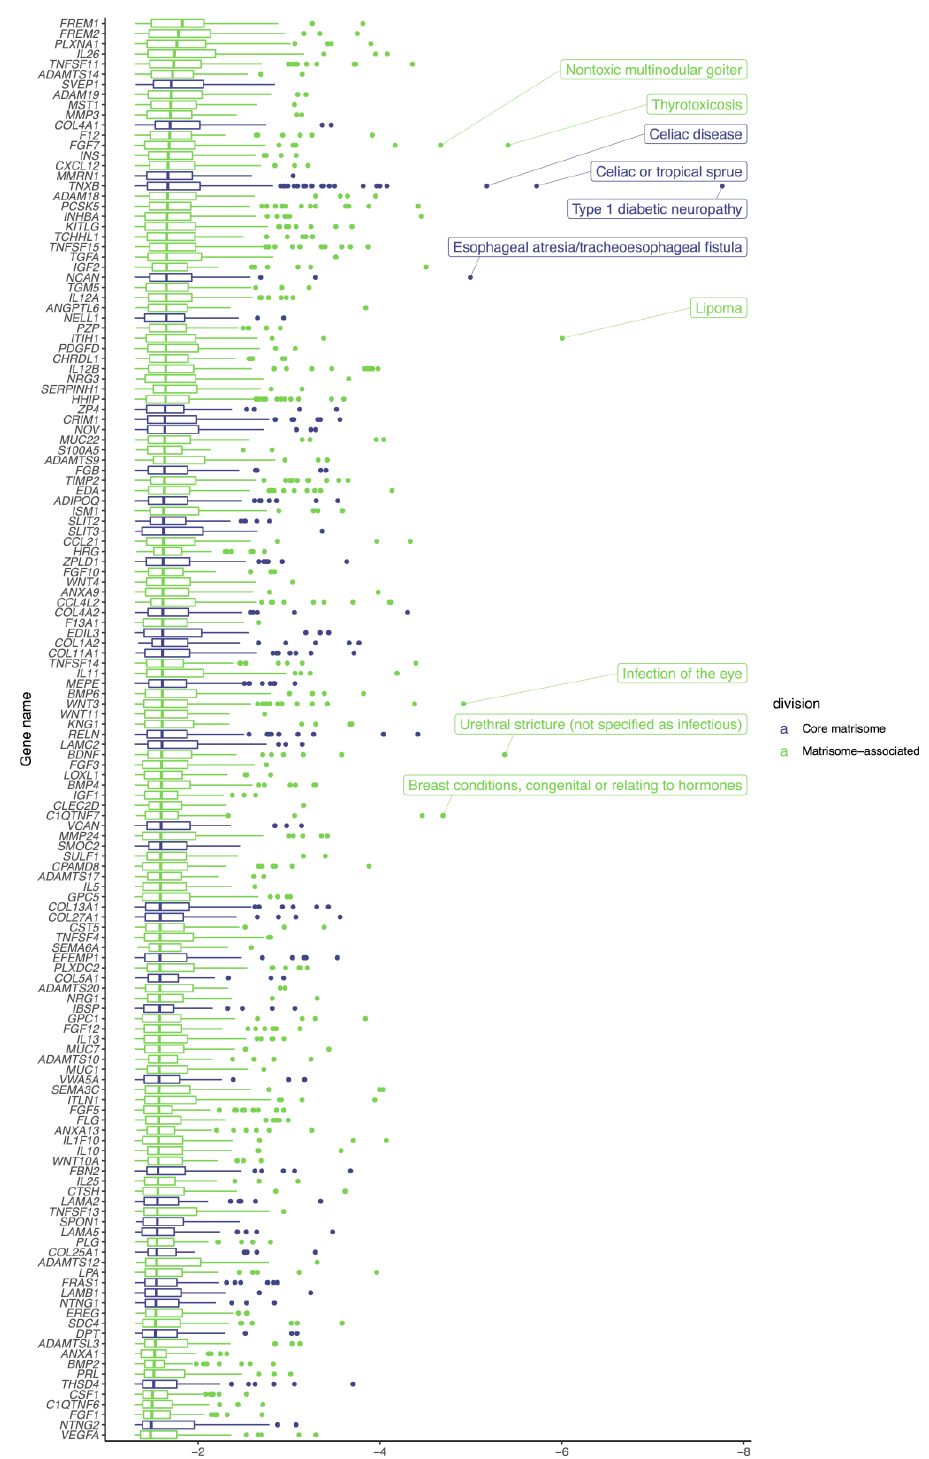
Figure 2. PheWAS of GWAS Catalog of SNVs. The human-matrisome genes are displayed on the y-axis, and the log10 p -value distribution of the associated phenotypes are shown as boxplots on the x-axis. Outliers are displayed as points, and only significantly associated phenotypes ( p -values < 0.05) are shown. The ten most significantly associated phenotypes ( p -value < 0.00001) are labeled. For more details, please see Supplementary Table S1. The phenotypes are colored according to the matrisome division with which the respective gene is associated (core matrisome genes in blue, matrisome-associated genes in green).